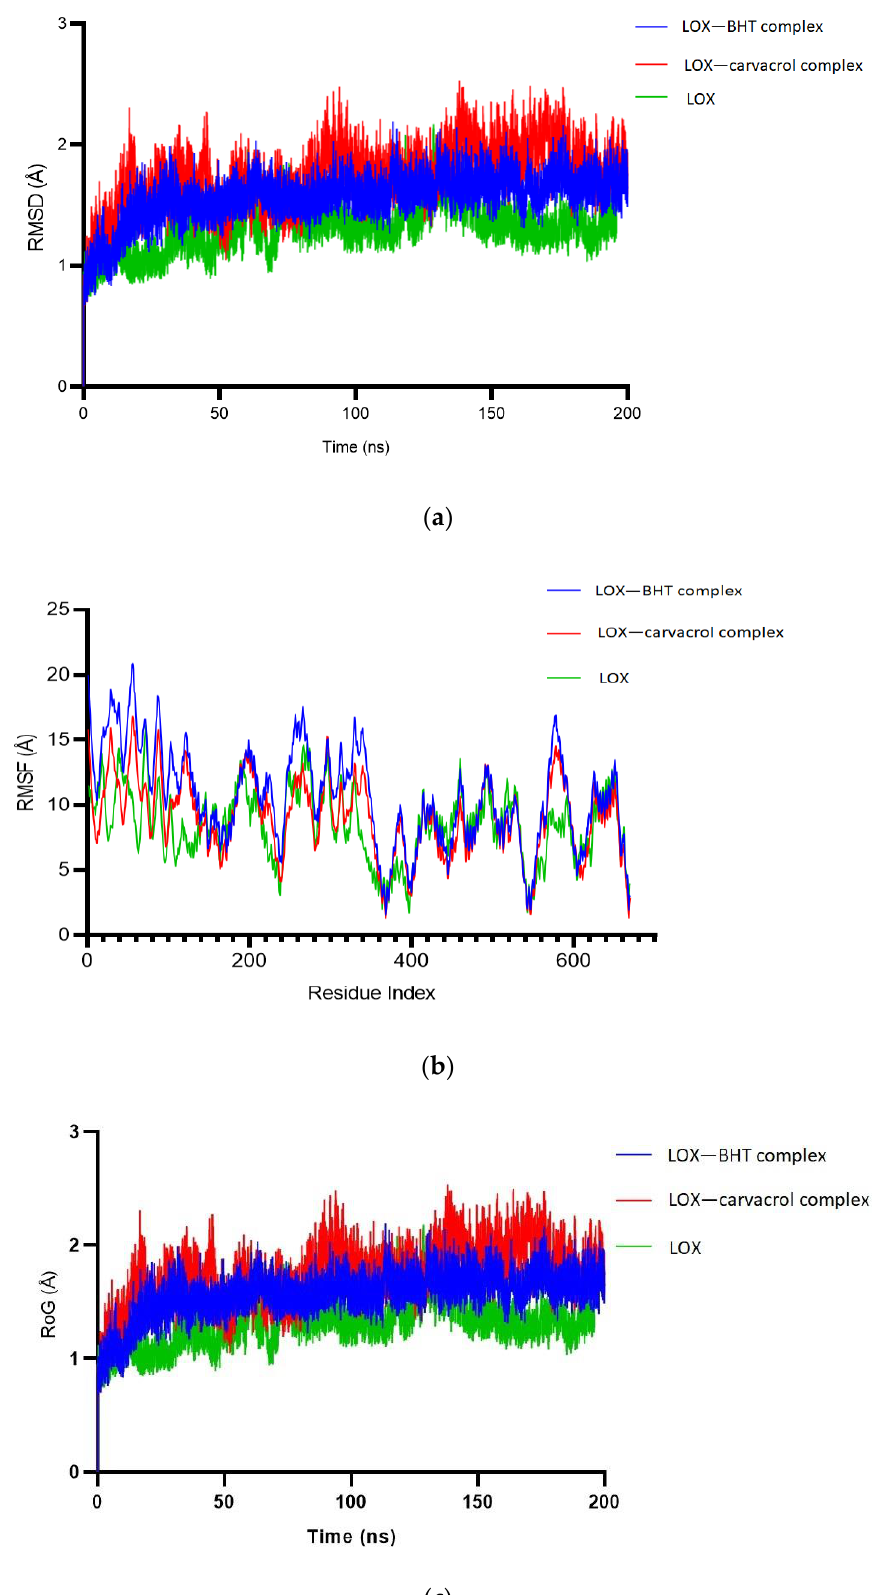
Figure 4. Molecular dynamics simulation of carvacrol and BHT docked on LOX, and LOX in the free state, for 200 nanoseconds; ( a ) root-mean-square deviation (RMSD); ( b ) root-mean-square fluctuation (RMSF); and ( c ) radius of gyration (RoG).